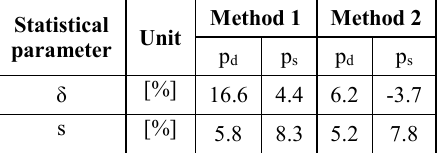
Table 2. Calculated mean relative errors and standard deviations of both